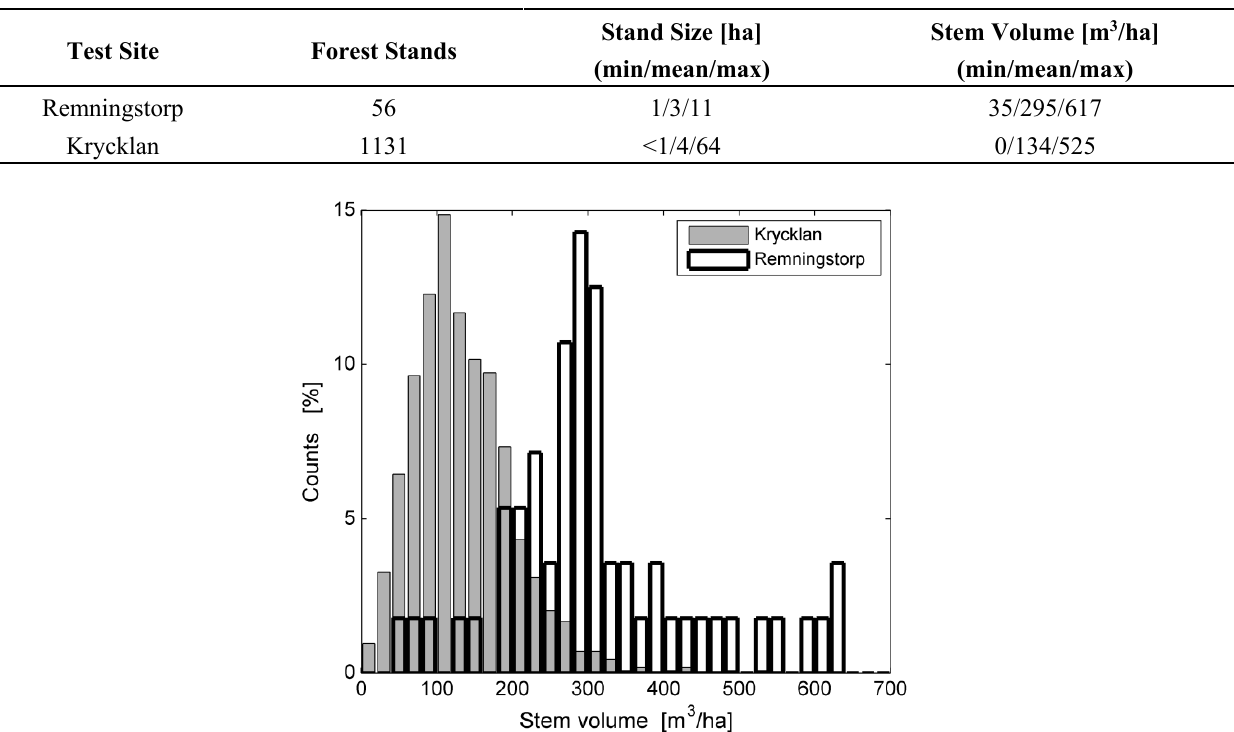
Figure 2. Bar chart of stem volume distribution in Remningstorp and Krycklan. Bars were grouped into intervals of 20 m 3